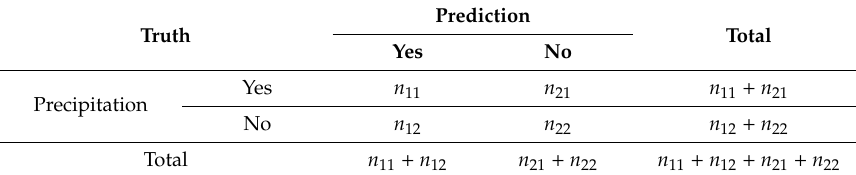
Table 3. Elements of the standard 2 × 2 contingency table associated with dichotomous prediction